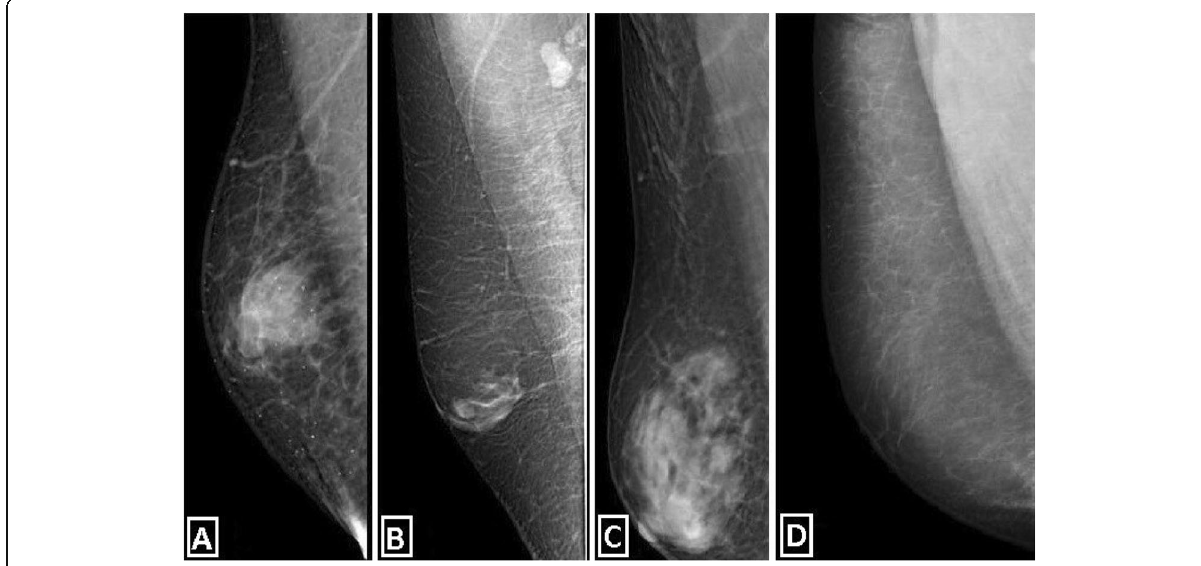
Fig. 4 Medio-lateral oblique mammograms of gynecomastia types and pseudogynecomastia as common causes of the male breast lump. Nodular ( a ), dendritic ( b ), and diffuse glandular ( c ) types of gynecomastia are demonstrated. Pseudogynecomastia which refers to breast enlargement in men primarily due to fatty tissue without associated fibroglandular tissue ( d